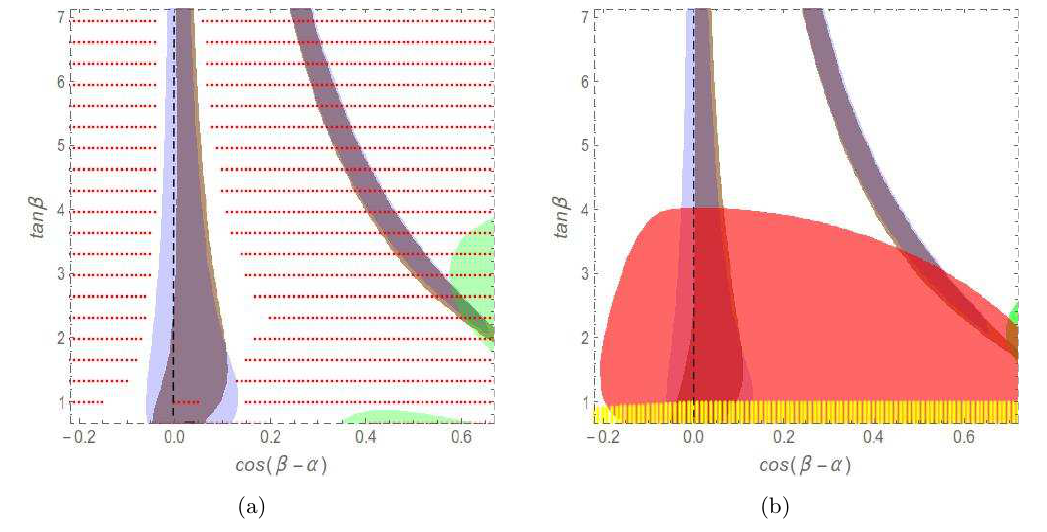
Figure 4 . Modification of alignment limit in BP3 for Type-II 2HDM. (a) m H 415 GeV, m A ∼ ∼ 480 GeV, m H ± 485 GeV. Red dotted area violate theoretical constraints, rest of the colour coding ∼ is the same as in figure 1. (b) m H 150 GeV, and m A m H ± 485 GeV. Solid red region is ruled ∼ ∼ ∼ out from A ZH . Rest of the colour coding is the same as in figure →